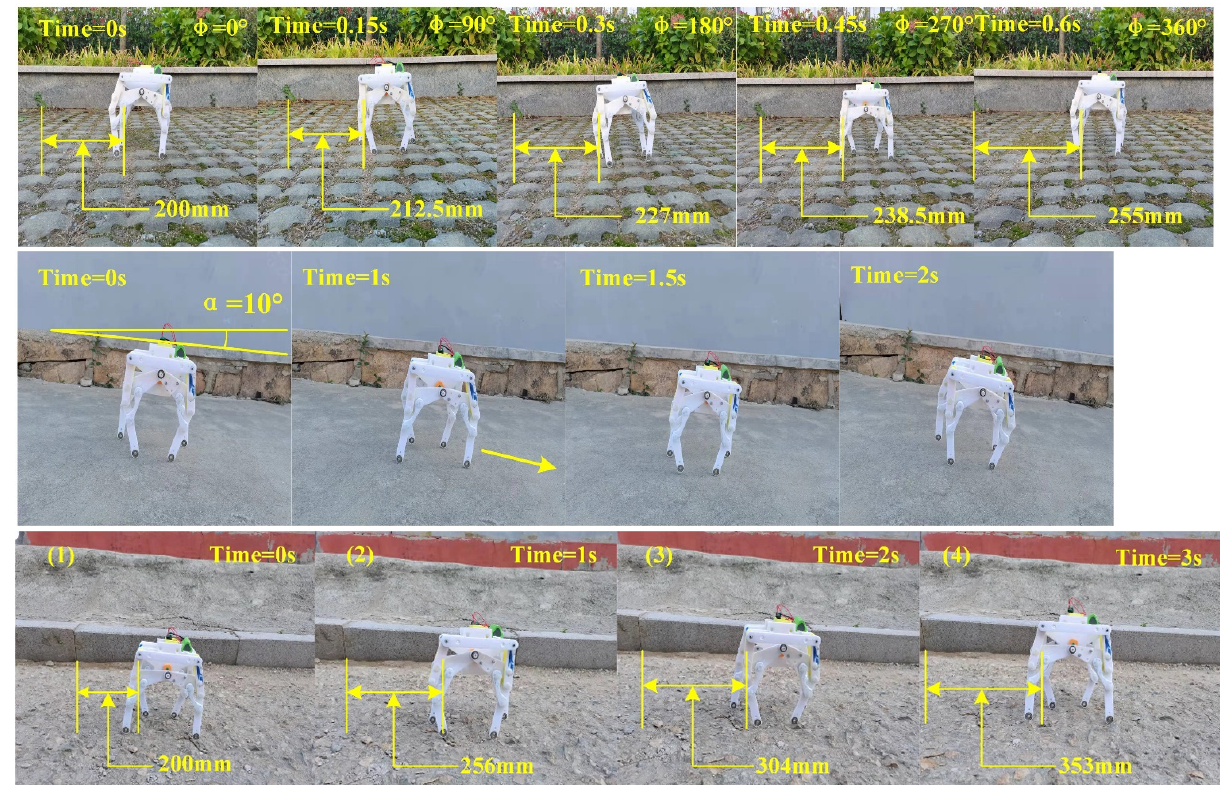
Figure 20. Walking test in a complex environment.